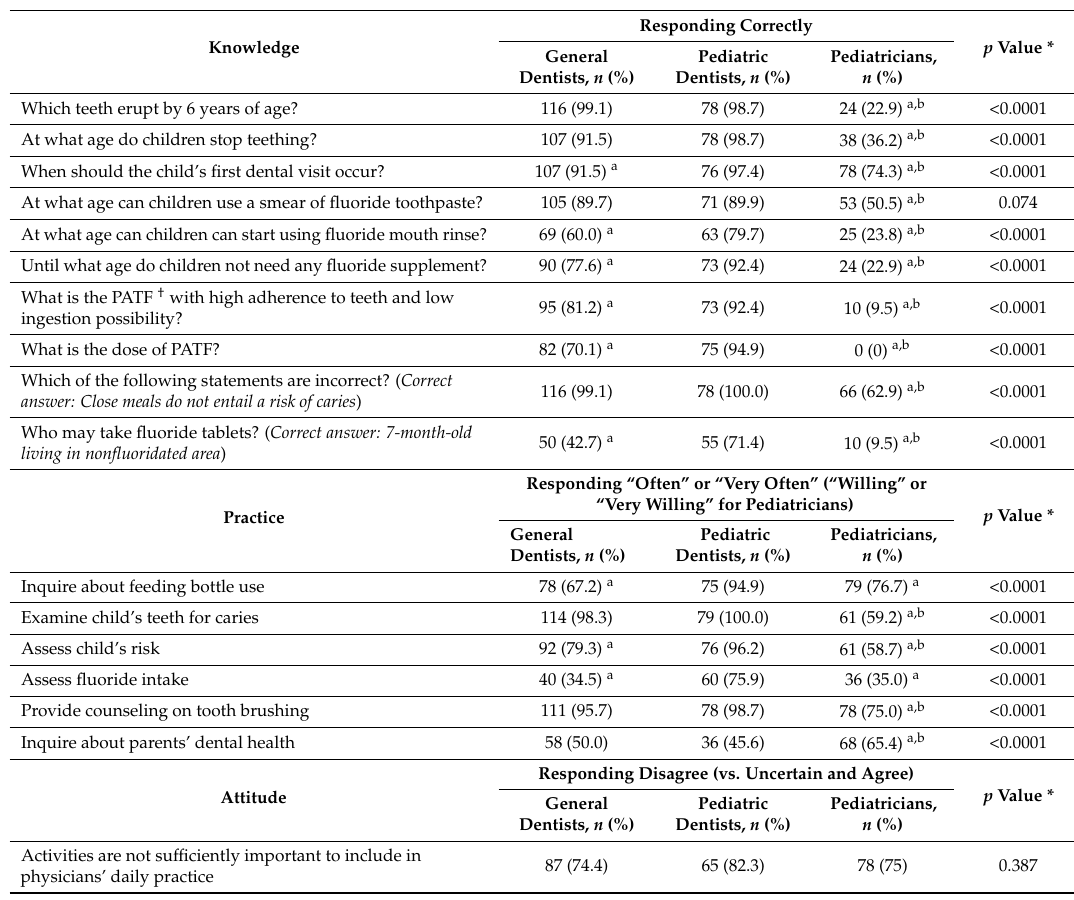
Table 2. Distribution of responses to knowledge, attitude, and practice (KAP) questions among three